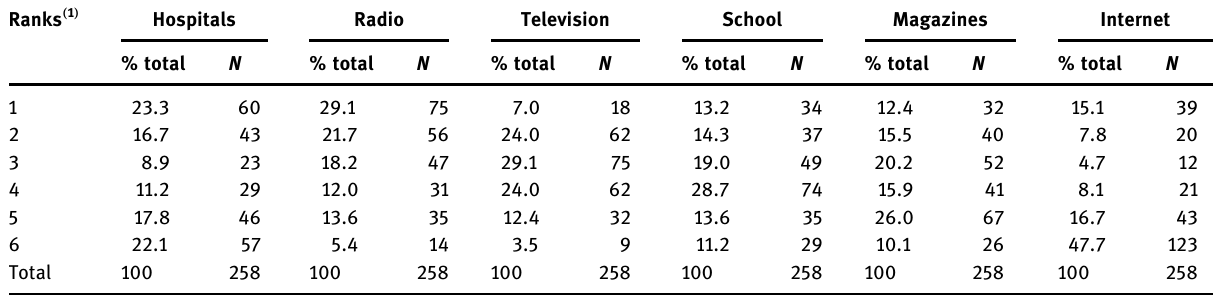
Table 2: Sources of information used by Lebanese participants to fi nd information about food and dietary fi bre Ranks ( 1 )